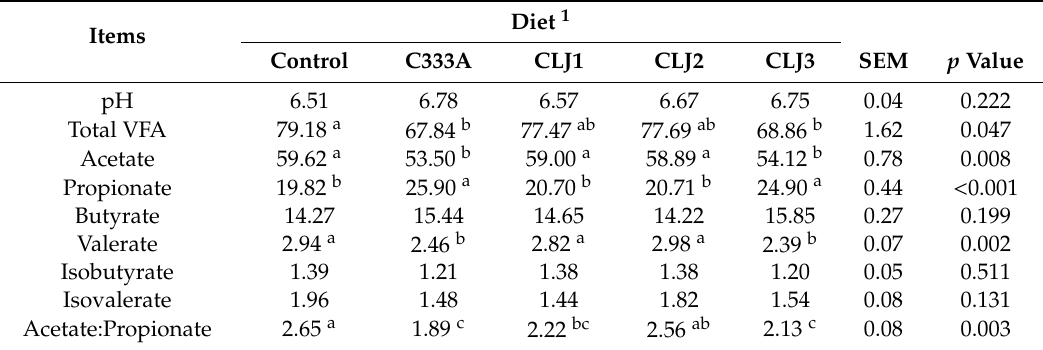
Table 4. E ff ect of dietary treatments on pH, total volatile fatty acids (VFA, mM) content, and molar proportions of individual VFA (% of total VFA) of Hu growing